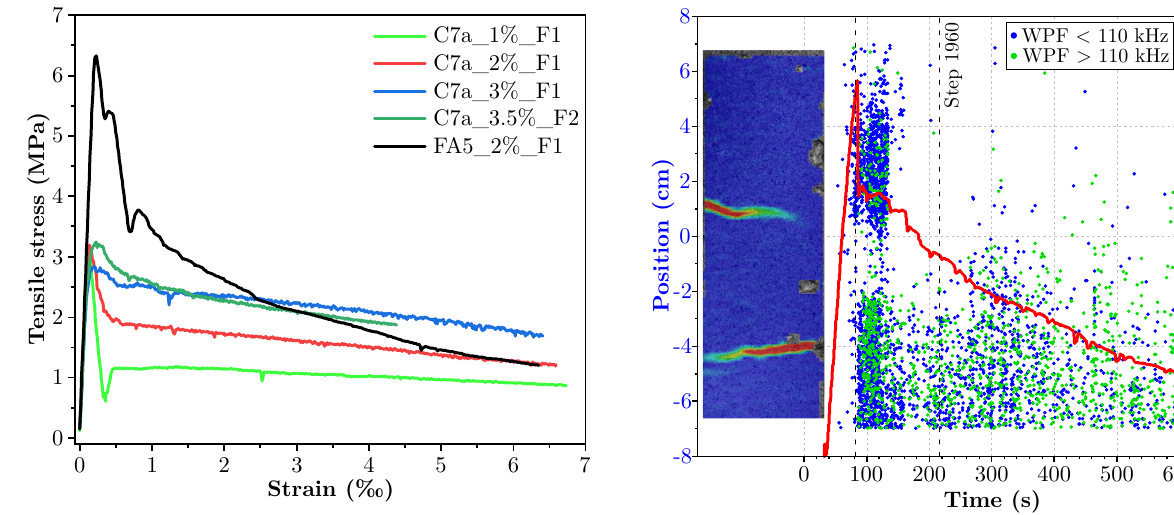
Figure 3. Results of the AE analysis for specimen